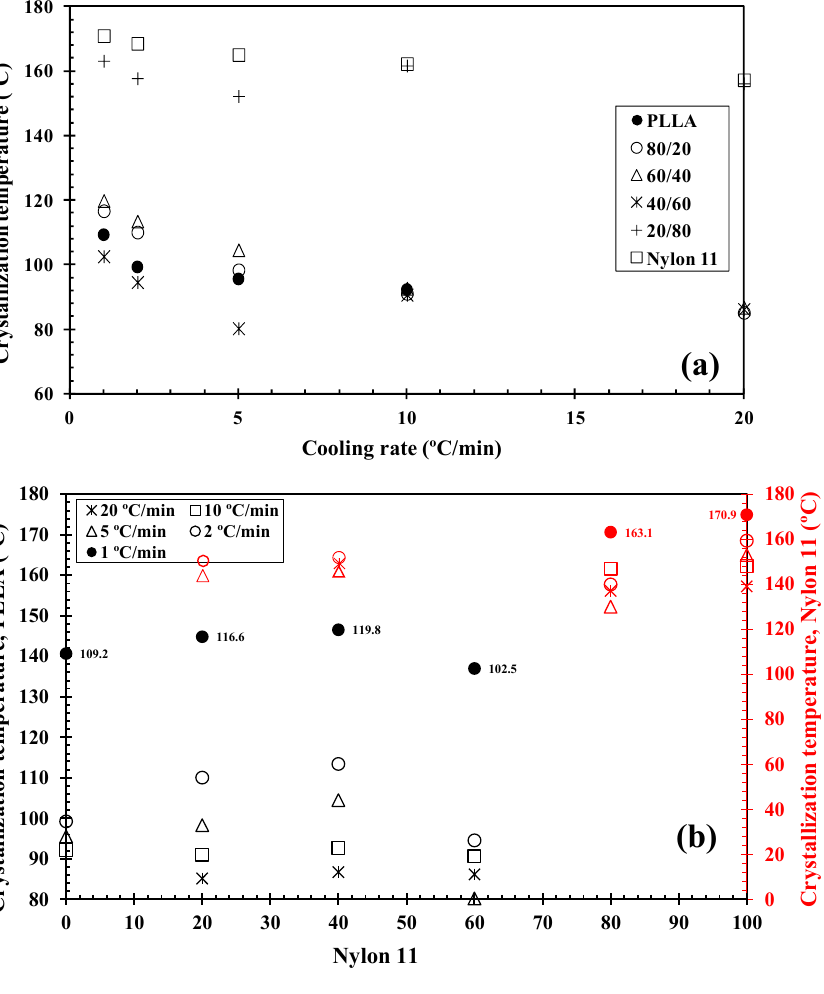
Figure 4. Variation in the PLLA/nylon 11 blends’ crystallization temperatures with ( a ) cooling rate and ( b ) composition.